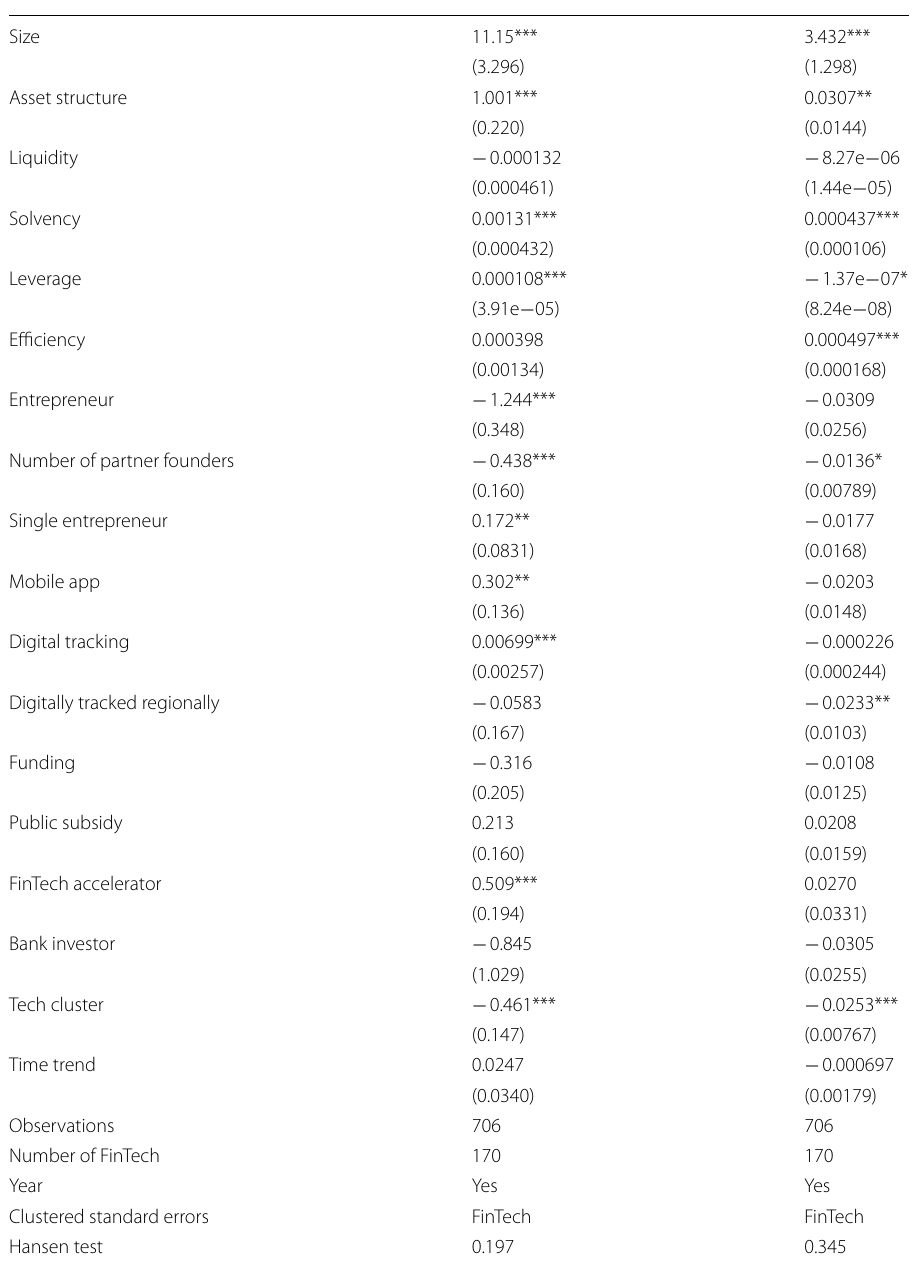
Table 15 Alternative estimation method: